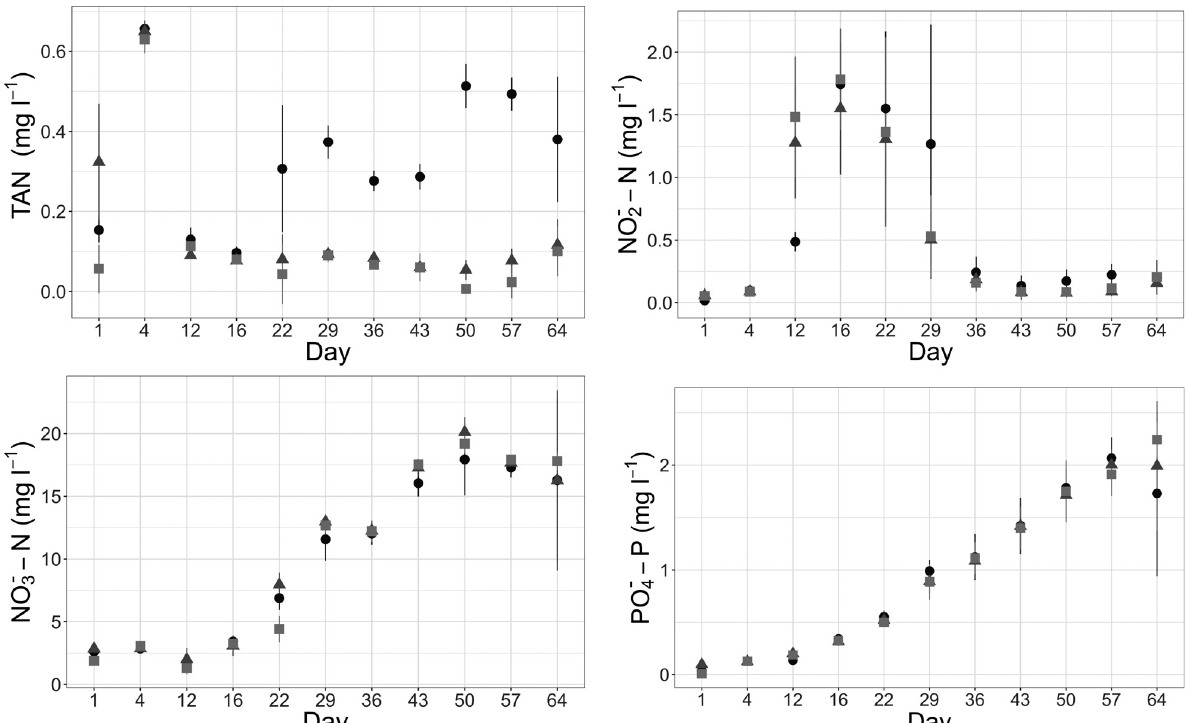
Fig. 3. Mean (±SD) concentrations of dissolved nutrients measured weekly in the tanks of the RAS systems (n = 3) over the course of the experiment. Black circles: Fish tanks; dark grey triangles: sea cucumber tanks; light grey squares: halophyte tanks; TAN: total ammonia